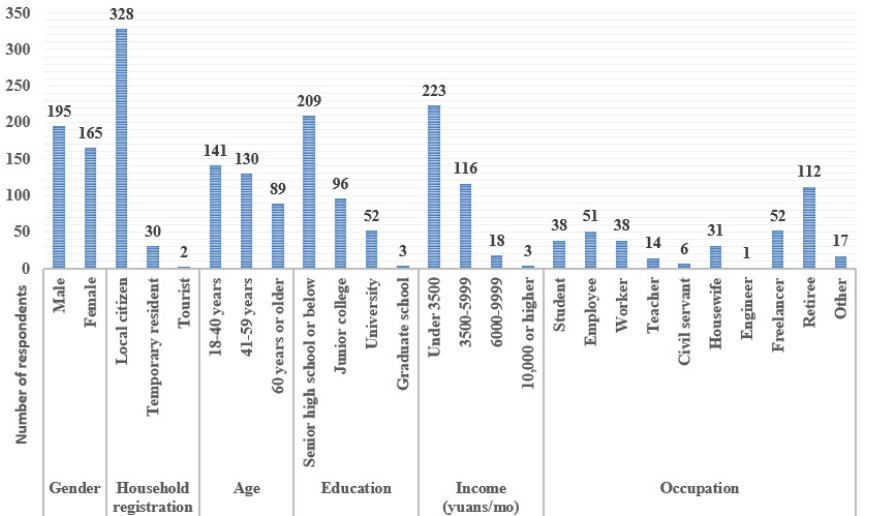
Figure 2. Basic information on respondents to Jining open-space questionnaire survey.